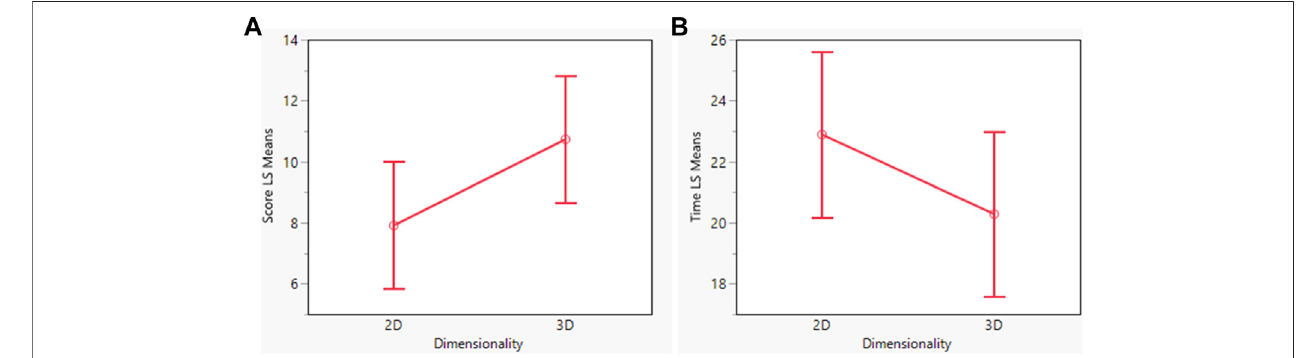
FIGURE 5 | LS means plots of score (A) and time (B) for the 2D and 3D IMRT.